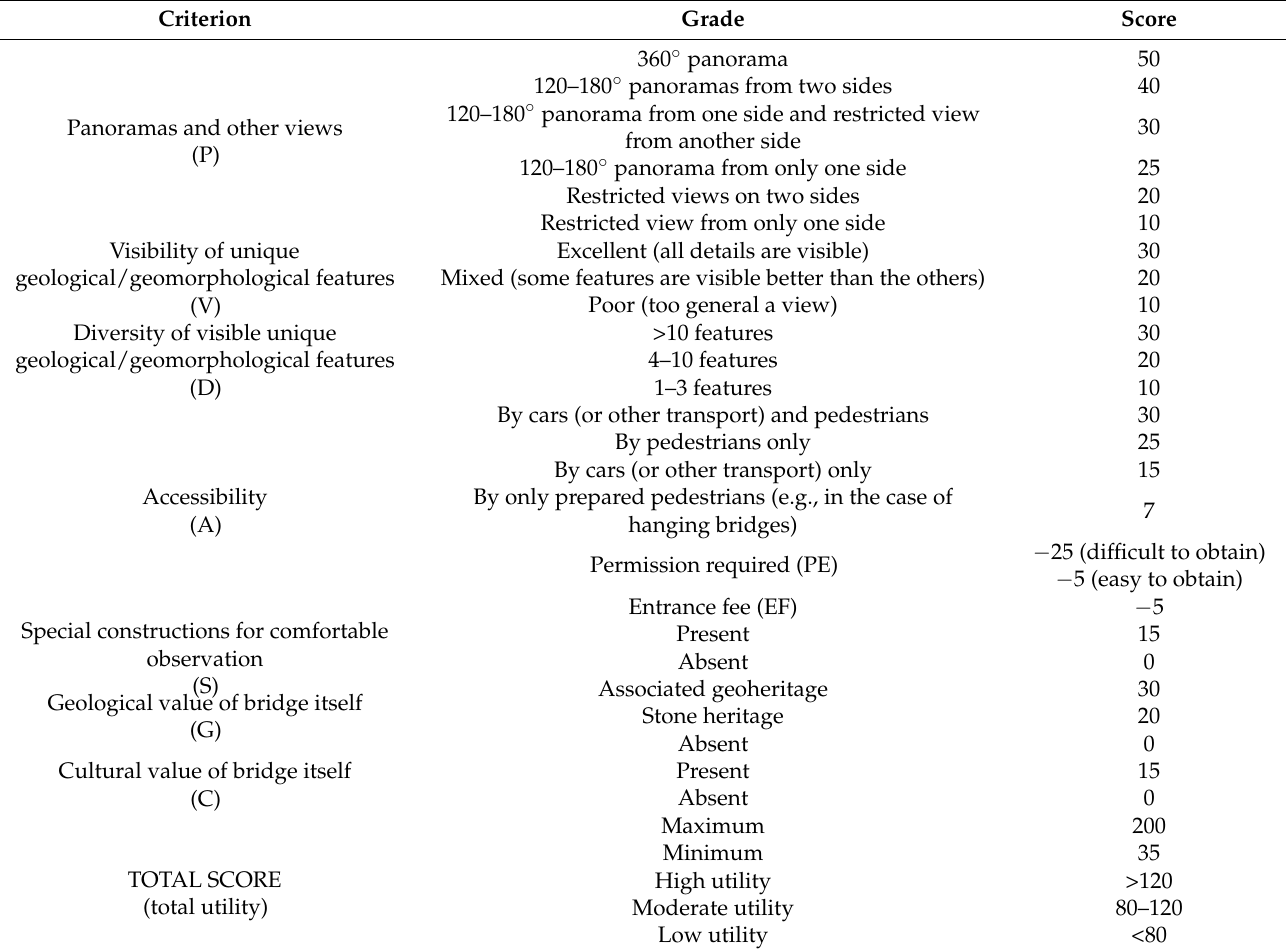
Table 1. Criteria proposed for semiquantitative assessment of bridge-based geoheritage